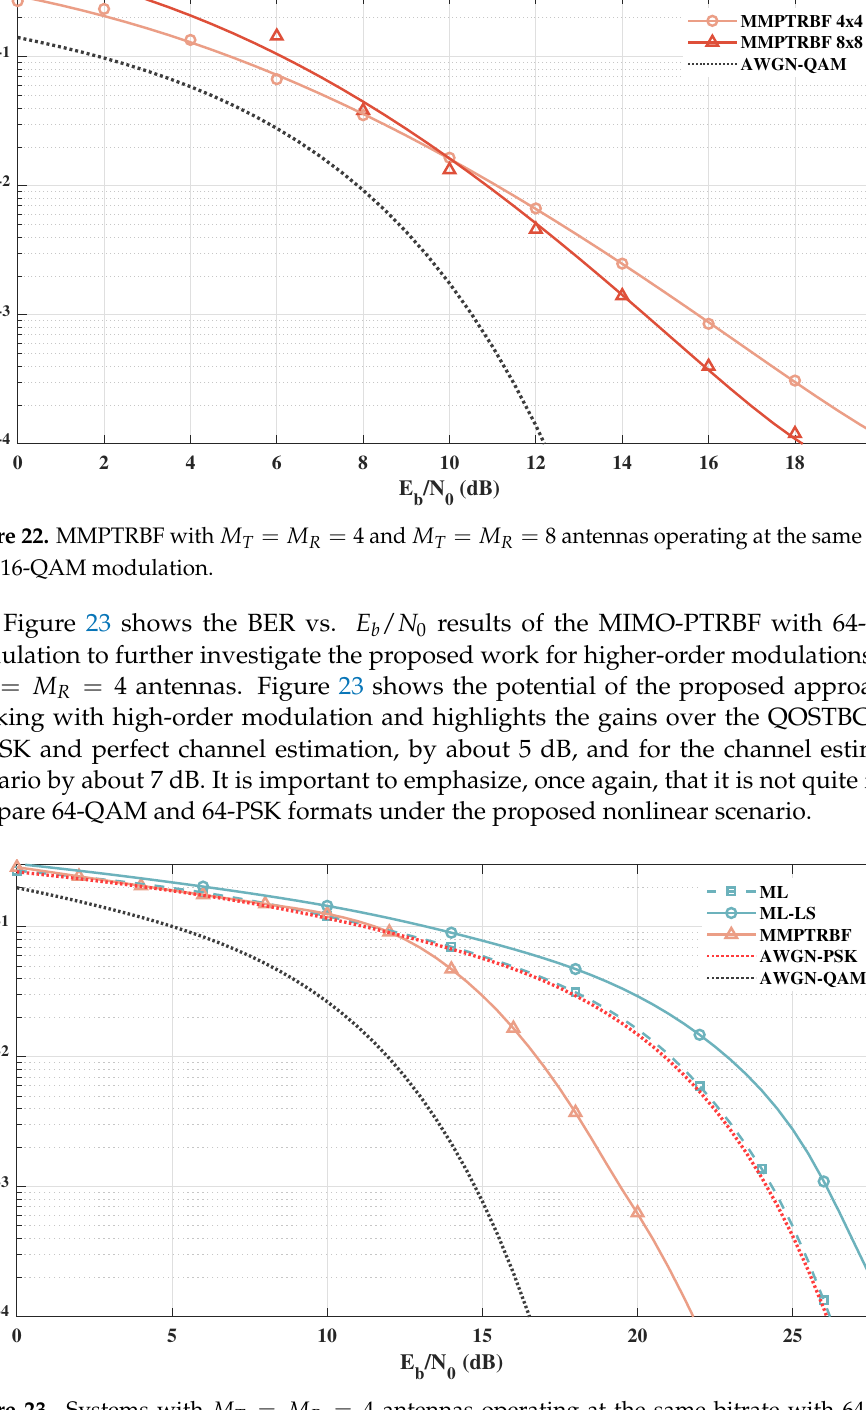
Figure 23. Systems with M T = M R = 4 antennas operating at the same bitrate with 64-QAM (MMPTRBF) and 64-PSK (ML-QOSTBC and